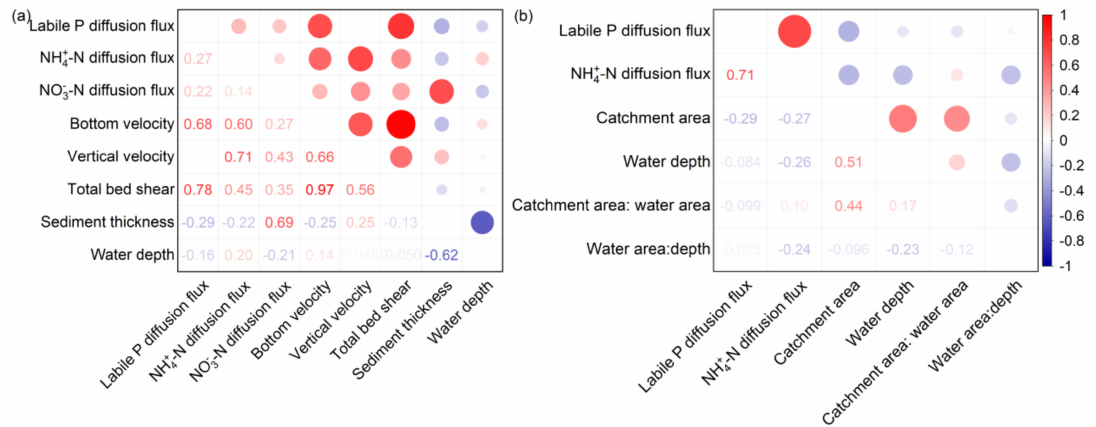
Figure 7. Correlation analysis among labile P, NH 4+ -N and NO 3 − -N diffusion fluxes, velocity, total bed shear, sediment thickness and water depth in Hongfeng Lake on 29 July 2019 (( a ), n = 6), correlation analysis among labile P, NH 4+ -N diffusion fluxes, water depth, catchment area and water area (data were referred to Table 3) (( b ), n =